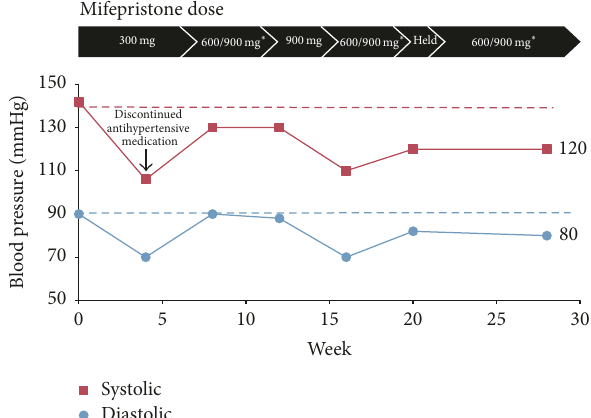
Figure 2: Change in blood pressure over time after initiating mifepristone treatment. ∗ Alternating daily doses of 600 and 900mg.